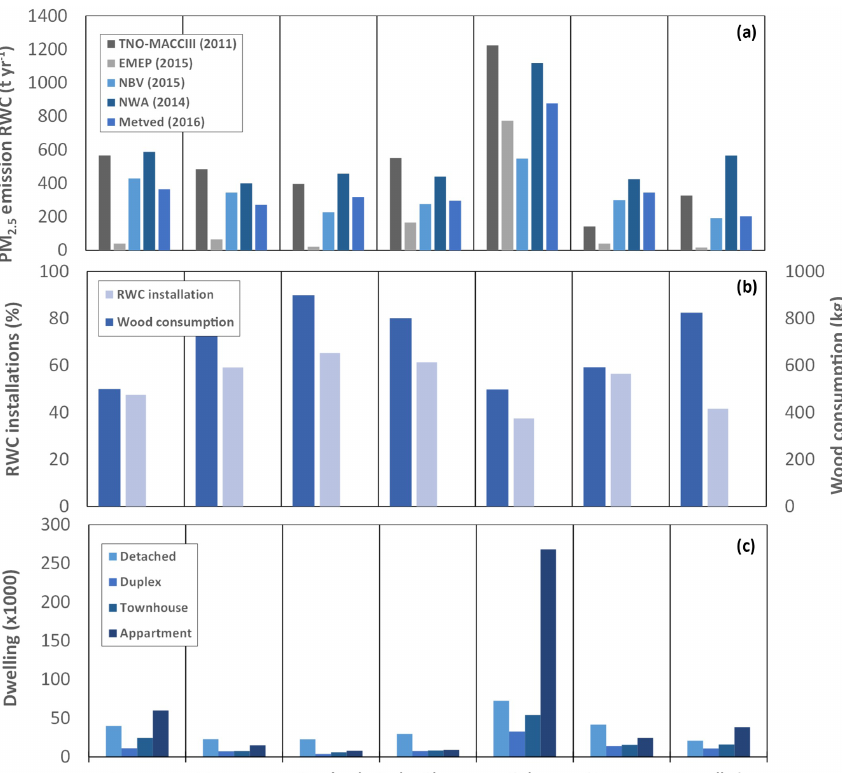
Figure 6. (a) Total emissions within domains shown in Fig. 3. (b) The percent of houses with at least one fireplace (left y axis) and the consumption per fireplace for each of the domains (right y axis). (c) The distribution of housing types for each